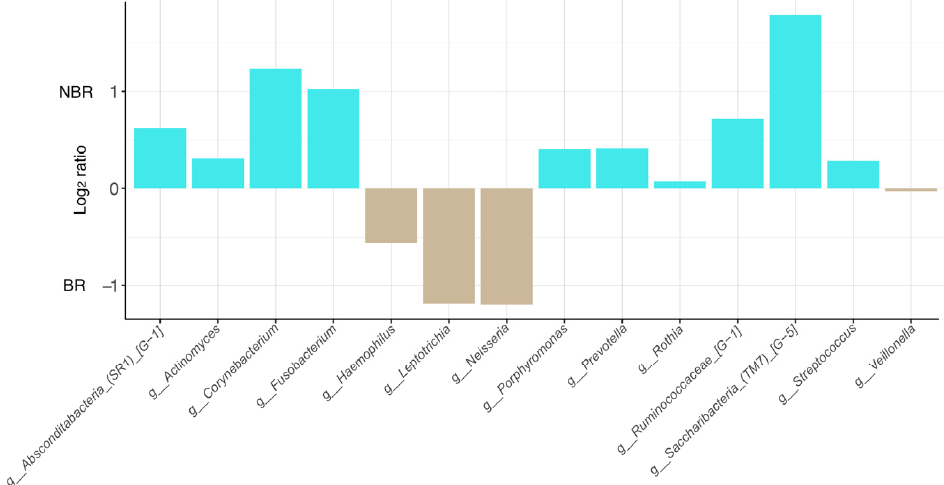
Figure 6. The relative frequency of biofilm-forming genera in different patient populations by toothbrush change (1–0: NBR; − 1–0: BR).